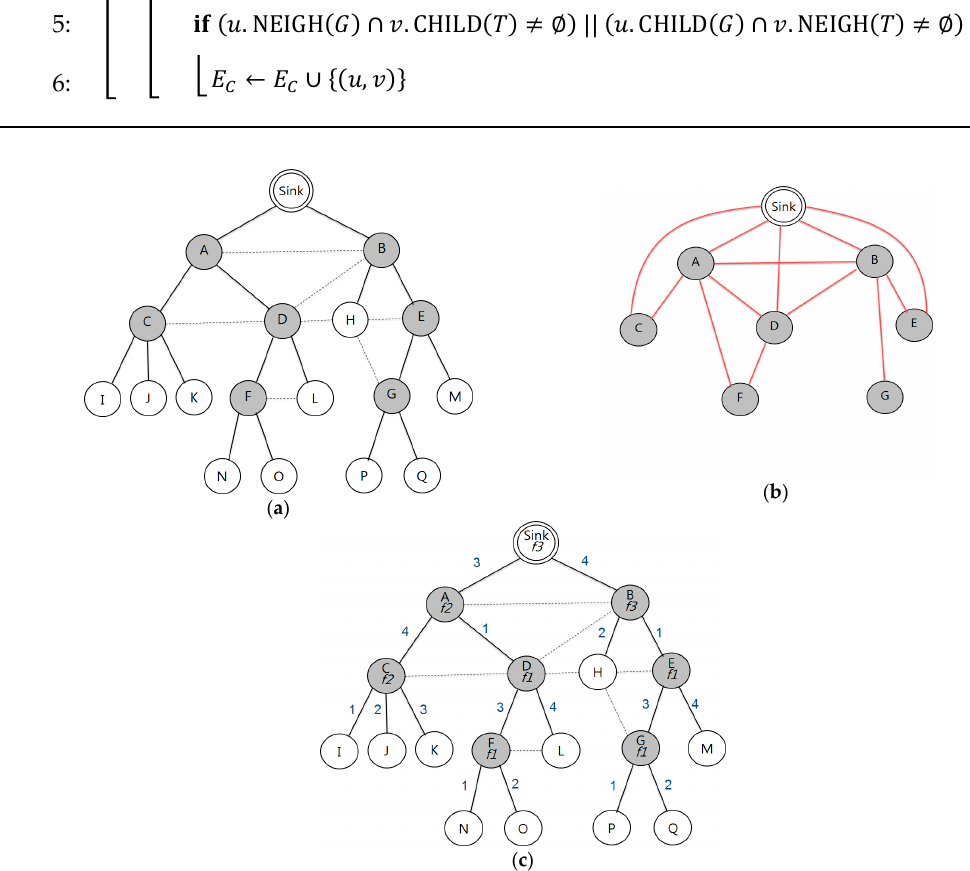
Figure 2. Example: ( a ) communication graph; ( b ) receiver-based constraint graph; and ( c ) minimal switching graph.